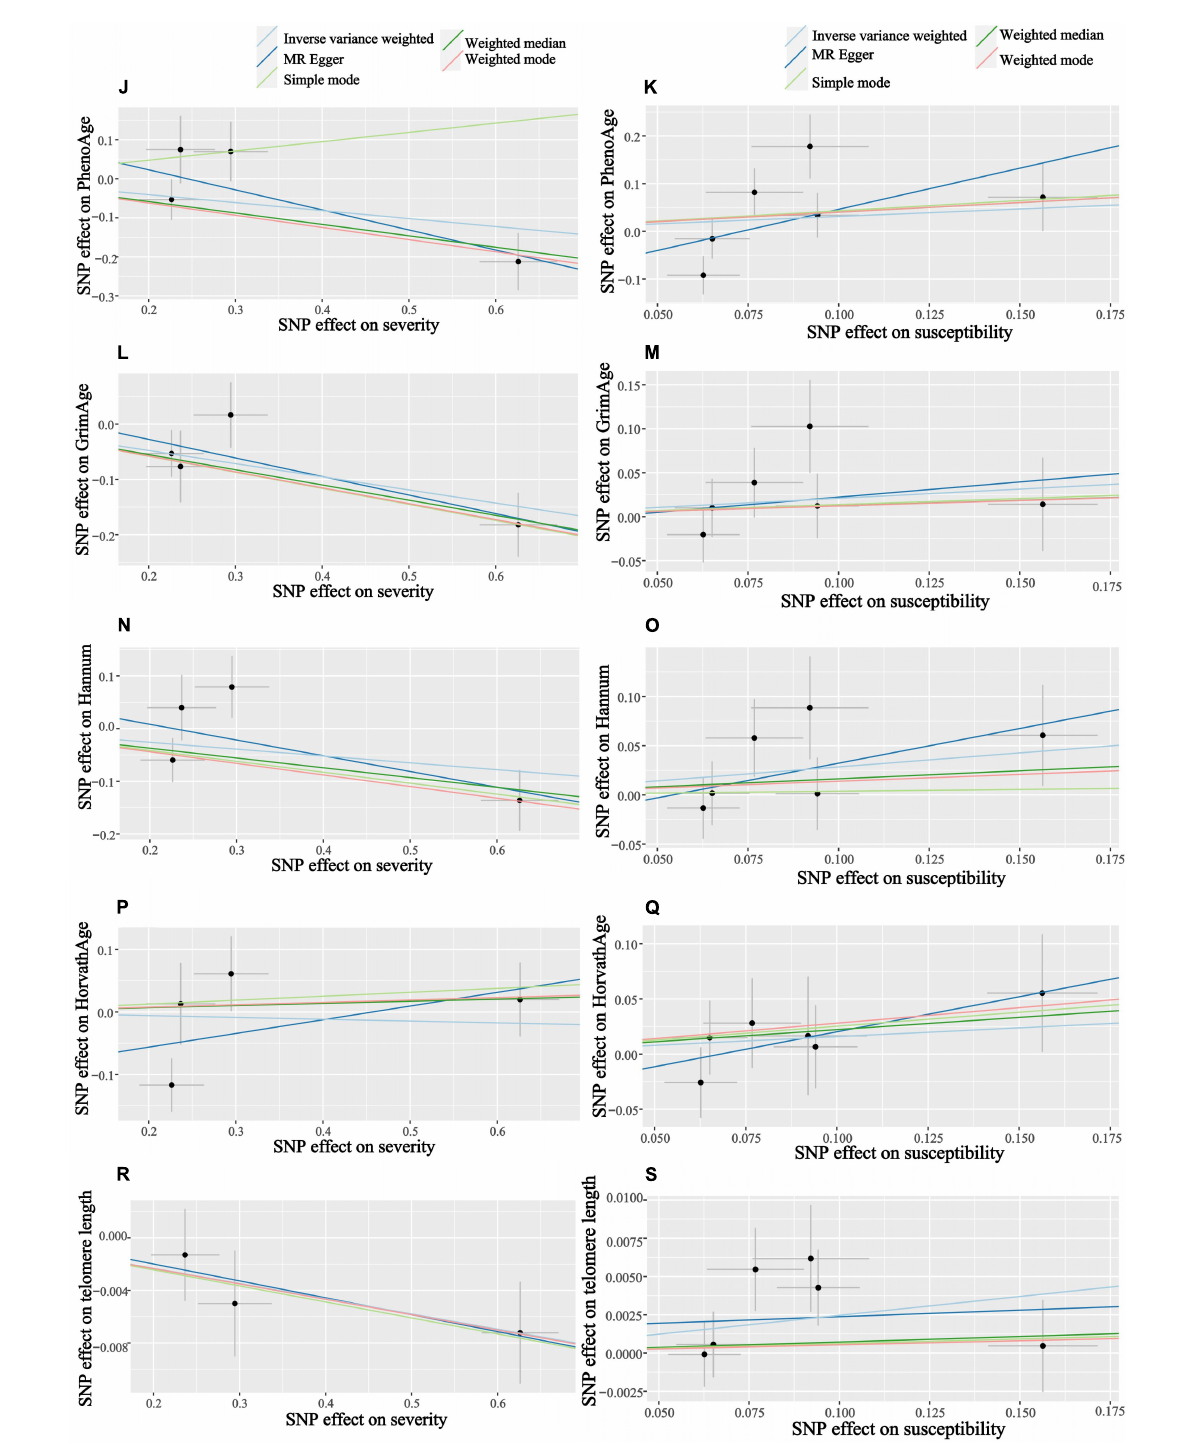
FIGURE5 Scatter plots of COVID-19 susceptibility and severity and aging. Horizontal ordinate: SNP effect on “exposure”; Vertical coordinates: SNP effect on “outcome.” (J) Exposure: severity, outcome: PhenoAge; (K) exposure: susceptibility, outcome: PhenoAge; (L) exposure: severity, outcome: GrimAge; (M) exposure: susceptibility, outcome: GrimAge; (N) exposure: severity, outcome: HannumAge; (O) exposure: susceptibility, outcome: HannumAge; (P) exposure: severity, outcome: HorvathAge; (Q) exposure: susceptibility, outcome: HorvathAge; (R) exposure: severity, outcome: telomere length; (S) exposure: susceptibility, outcome: telomere